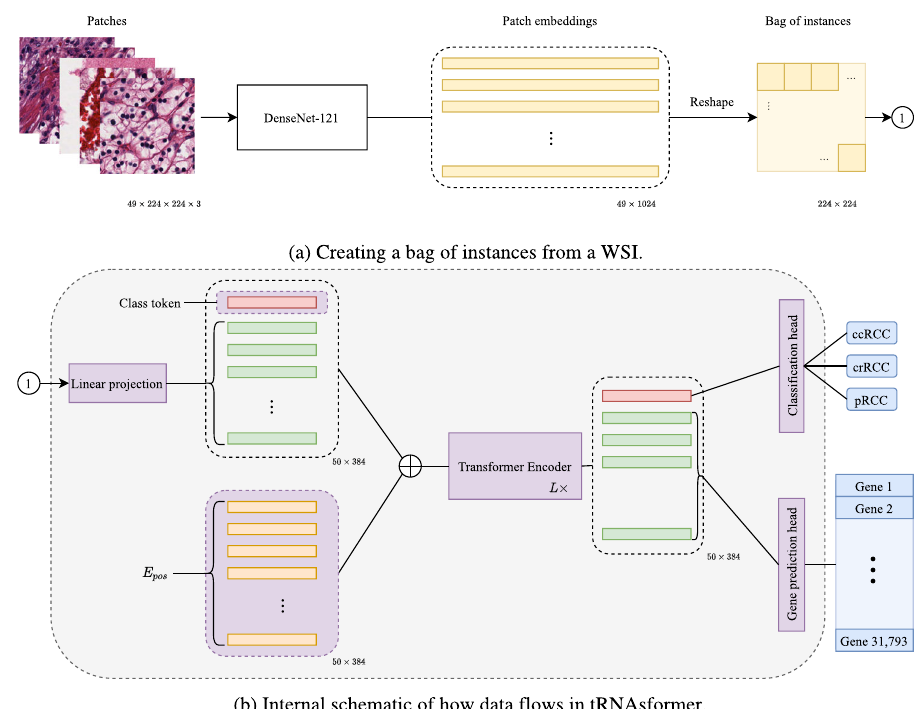
Fig. 1 A diagram showing how tRNAsformer works. a 49 tiles of size 224 × 224 × 3 selected from 49 spatial clusters in a WSI are embedded with a DenseNet-121. The outcome is a matrix of size 49 × 1024 as DenseNet-121 has 1024 deep features after the last pooling. Then the matrix is reshaped and rearranged to 224 × 224 matrix in which each 32 × 32 block corresponds to a tile embedding 1 × 1024. b Applying a 2D convolution with kernel 32, stride 32, and 384 kernels, each 32 × 32 block has linearly mapped a vector of 384 dimensional. Next, a class token is concatenated with the rest of the tile embeddings, and Epos is added to the matrix before entering L Encoder layers. The fi rst row of the outcome, which is associated with the class token, is fed to the classi fi cation head. The rest of the internal embeddings that are associated with all tile embeddings are passed to the gene prediction head. All parts with learnable variables are shown in